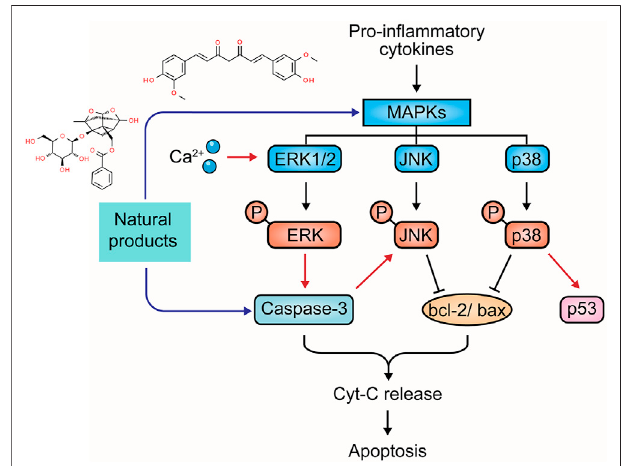
FIGURE 4 | Natural products modulate apoptosis of IECs through MAPK mediated pathway.